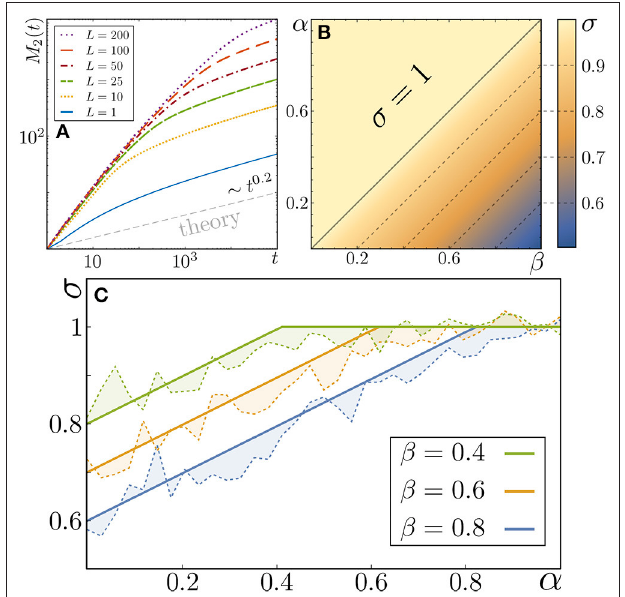
FIGURE 2 | (A) MSD of a particle moving in an system of compartments of equal length and boundary transmittances distributed following (11), with α = 0.2. All curves are calculated for the microscale and tend to the predicted subdiffusive motion given by (13). A larger L leads to a larger time for the onset of subdiffusion to occur. The dashed bottom line corresponds to the mesoscale and coincides with the theoretical prediction. (B) Value of the exponent of the MSD in a system with stochastic compartment sizes and boundary transmittance, given by (15). (C) Comparison between the predicted results of the previous case and numerical simulations of the microscopic walk (dashed